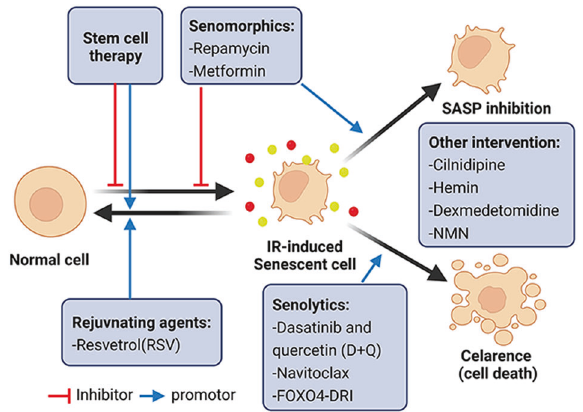
Fig. 5 Therapies that target cellular senescence to alleviate IR injury. Several kinds of intervention including senolytics, seno- morphics, rejuvenating agents, stem cell therapy, and other intervention, are developed to attenuate the deterioration brought by senescent